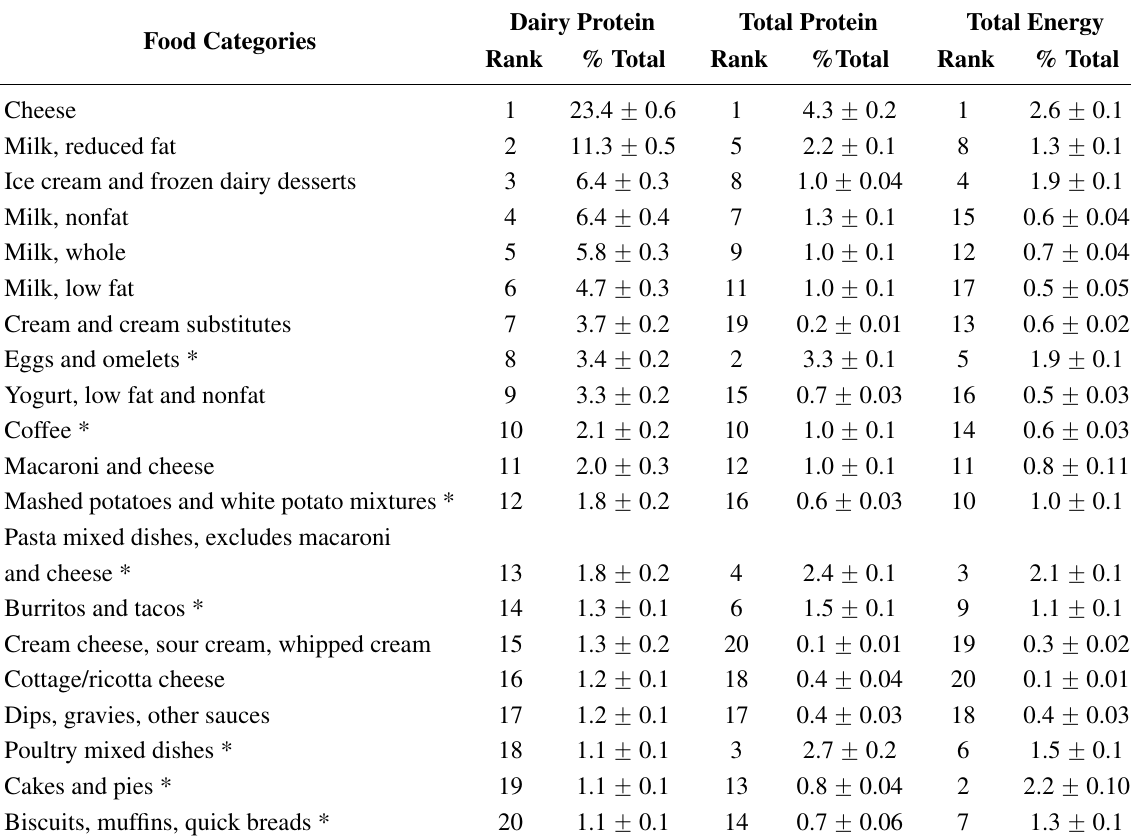
Table 3. Food sources of dairy protein (providing at least 1% dairy protein) and energy among US adults age 19 years and older. Data from NHANES